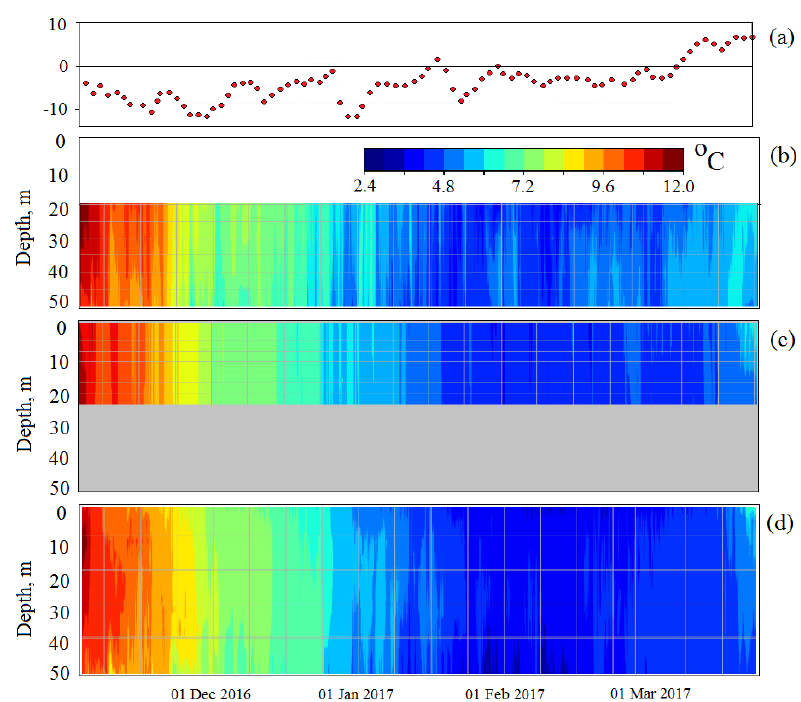
Figure 15. (a) Air temperature ( ◦ C) at 2m height from ERA-Interim reanalysis data corresponding to the point 42 ◦ 20 (cid:48) N, 77 ◦ 30 (cid:48) E in the central part of the lake. (b) Water temperature record from thermistor chain in the Tyup canyon. (c) Water temperature record from thermistor chain on the shelf between the Tyup and the Jyrgalan canyons. (d) Water temperature record from thermistor chain in the Jyrgalan canyon.